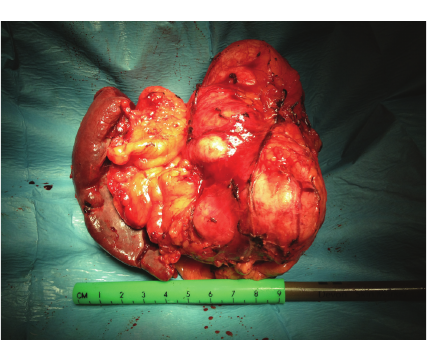
Figure 1: Macroscopic image of the oncocytoma.